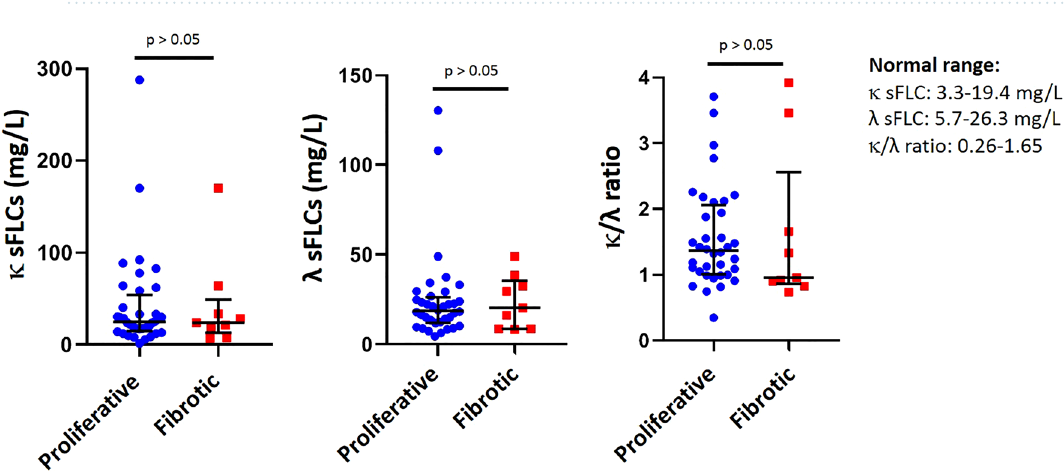
Figure 3. Levels of κ and λ serum free light chains and the κ/λ ratio were not different between proliferative (n = 36) and fibrotic (n = 9) phenotypes (median with interquantile range). Statistics performed by Mann– Whitney U test. sFLC serum free light